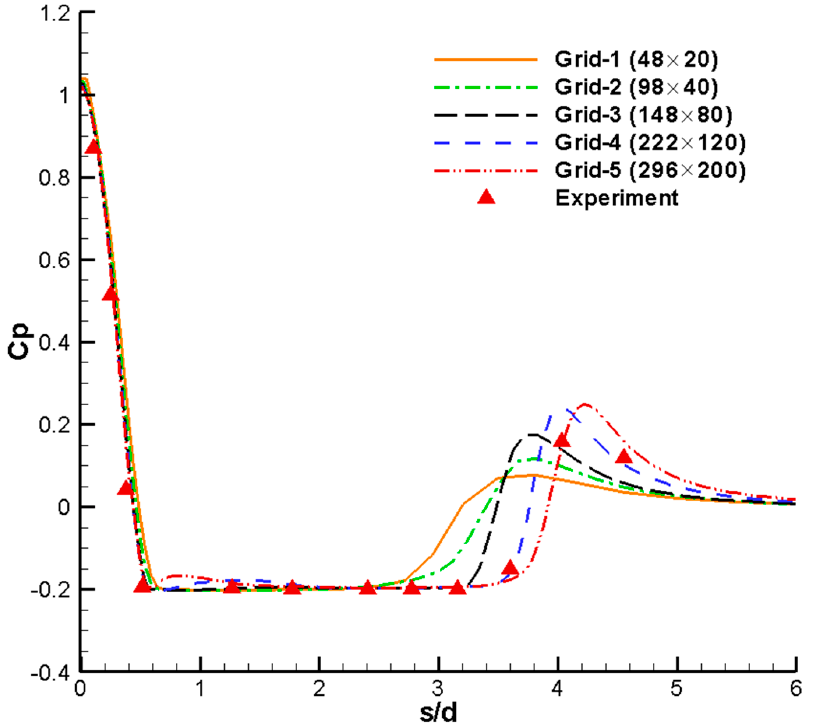
Figure 1. Sensitivity of grid resolution to surface pressure prediction.